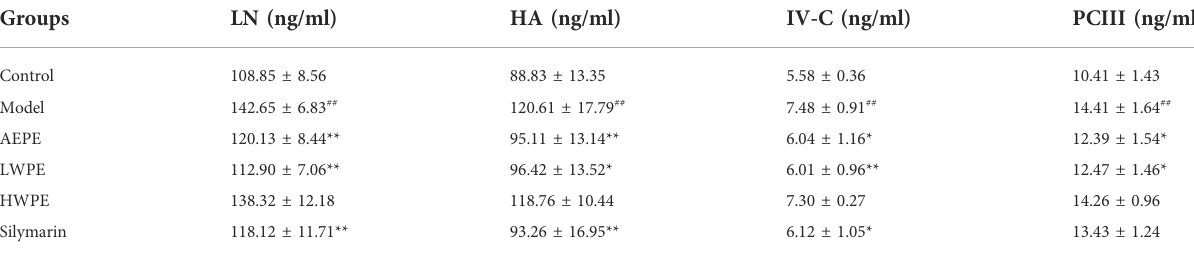
TABLE 1 Effects AEPE and its fractions on the serum contents of LN, HA, IV-C and PCIII in CCl 4 induced rat liver fi brosis.